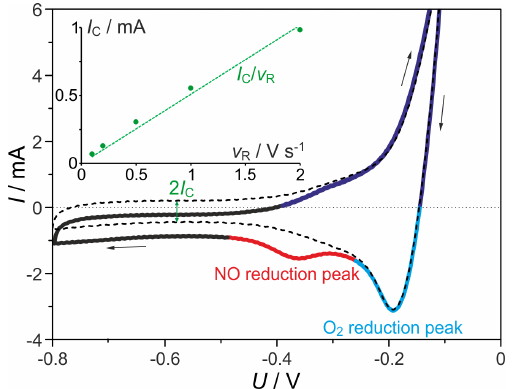
Figure 7. Typical CVs in NO containing gas and in pure N 2 (dashed line), O 2 pumping in current (dark blue line), O 2 -related peak (light blue line), NO-related peak (red line). Inset: hysteresis dependency on the scan rate ( v r ) for the baseline CVs in pure nitrogen gas flow for the double-layer capacitance calculation ( I C /v R = C DL ). c (NO) = 0ppmv; c (O = 0.2ppmv; flow rate = 10sccm; T = 650 ◦ C. 2 )